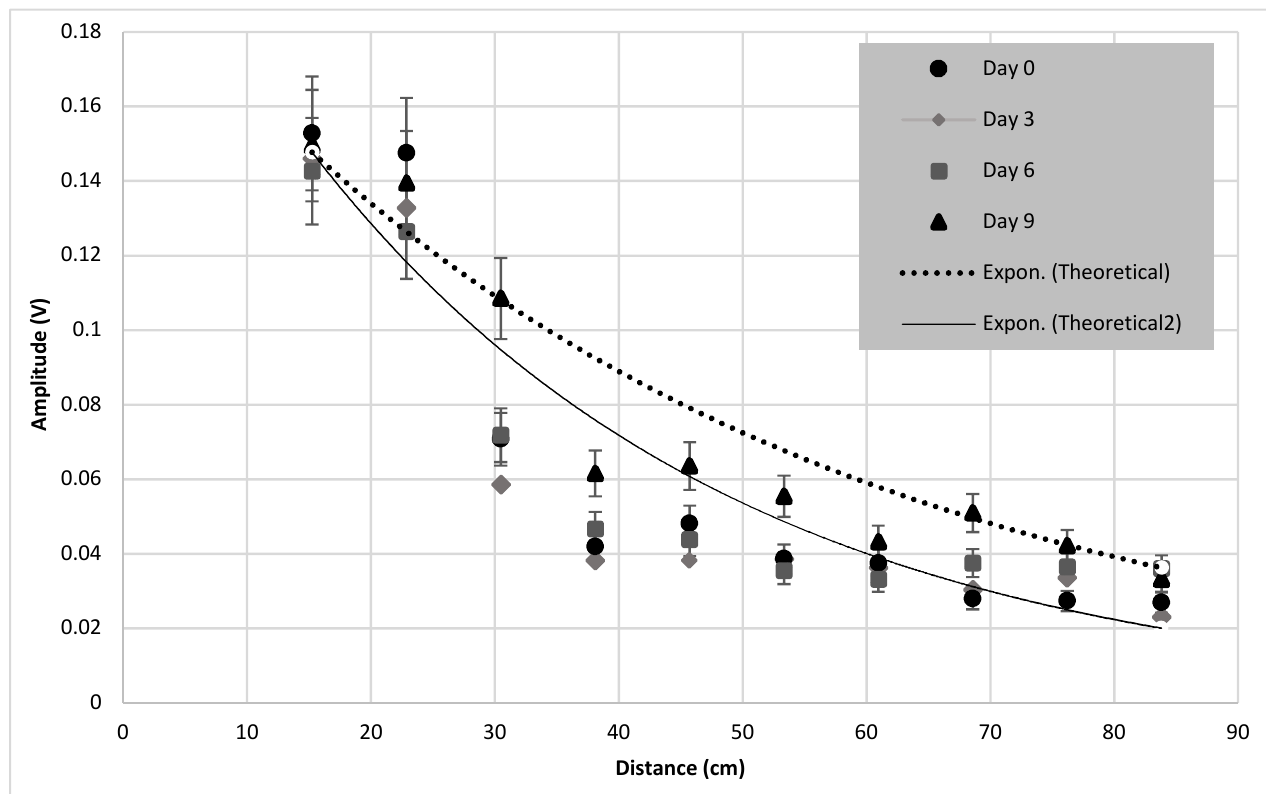
Figure 5. Specimen A UGWL data: days 0, 3, 6 and